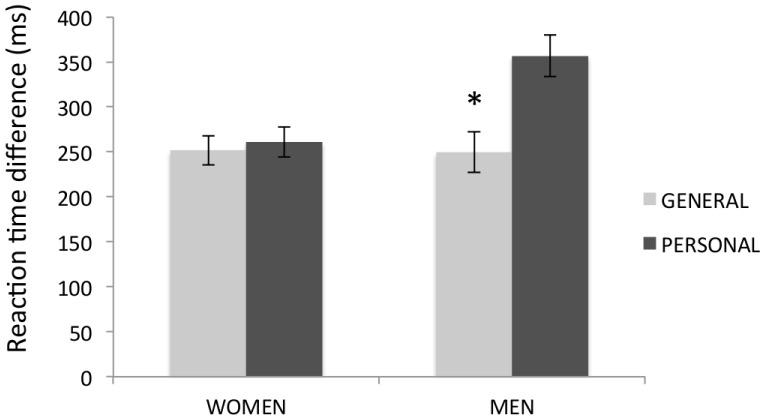
Differential reaction times (RT) of men and women for general and personal information.Error bars represent standard error of the mean. In men, differential RT for personal information were significantly longer than for general information, whereas in women no such differences were observed.